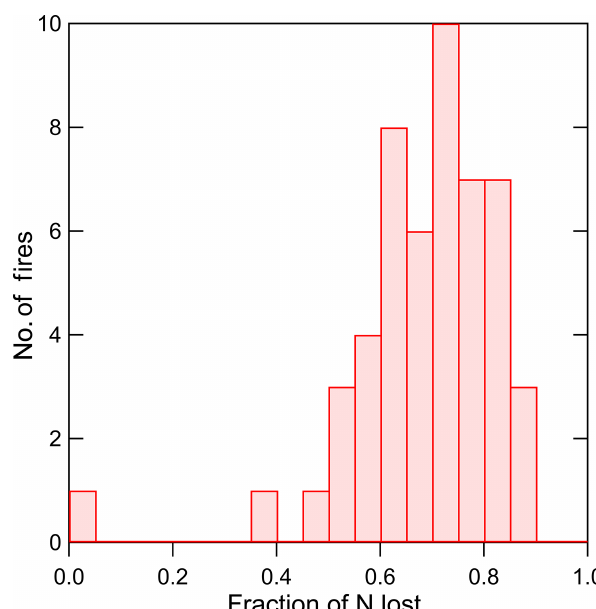
Figure 4. The histogram of the fraction of N loss to N 2 and N 2 O es- timated from the mass balance analysis described in the Supplement (52